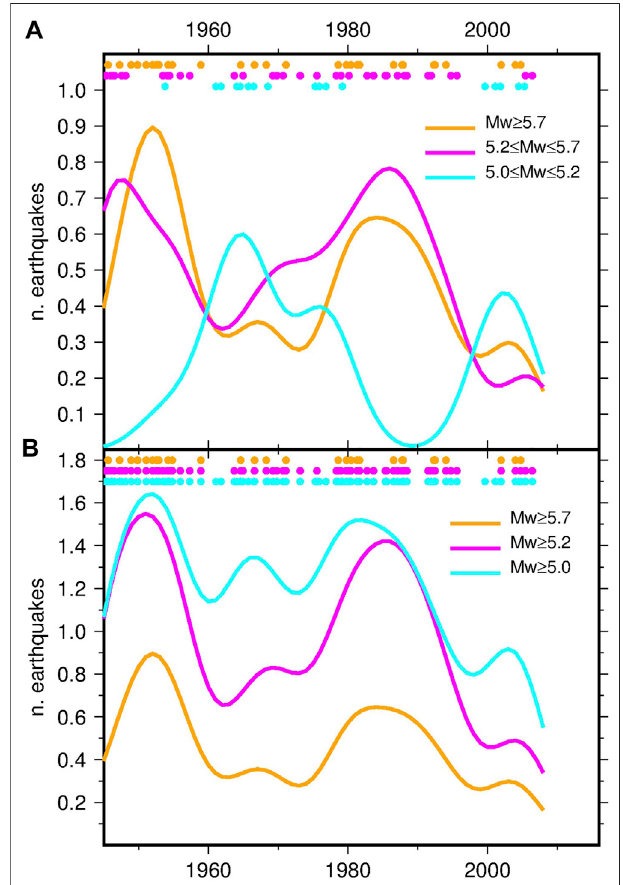
FIGURE 11 | Smoothed time densities of earthquakes in Southern California since 1945 computed for various magnitude ranges. The dots indicate the time of occurrence of the